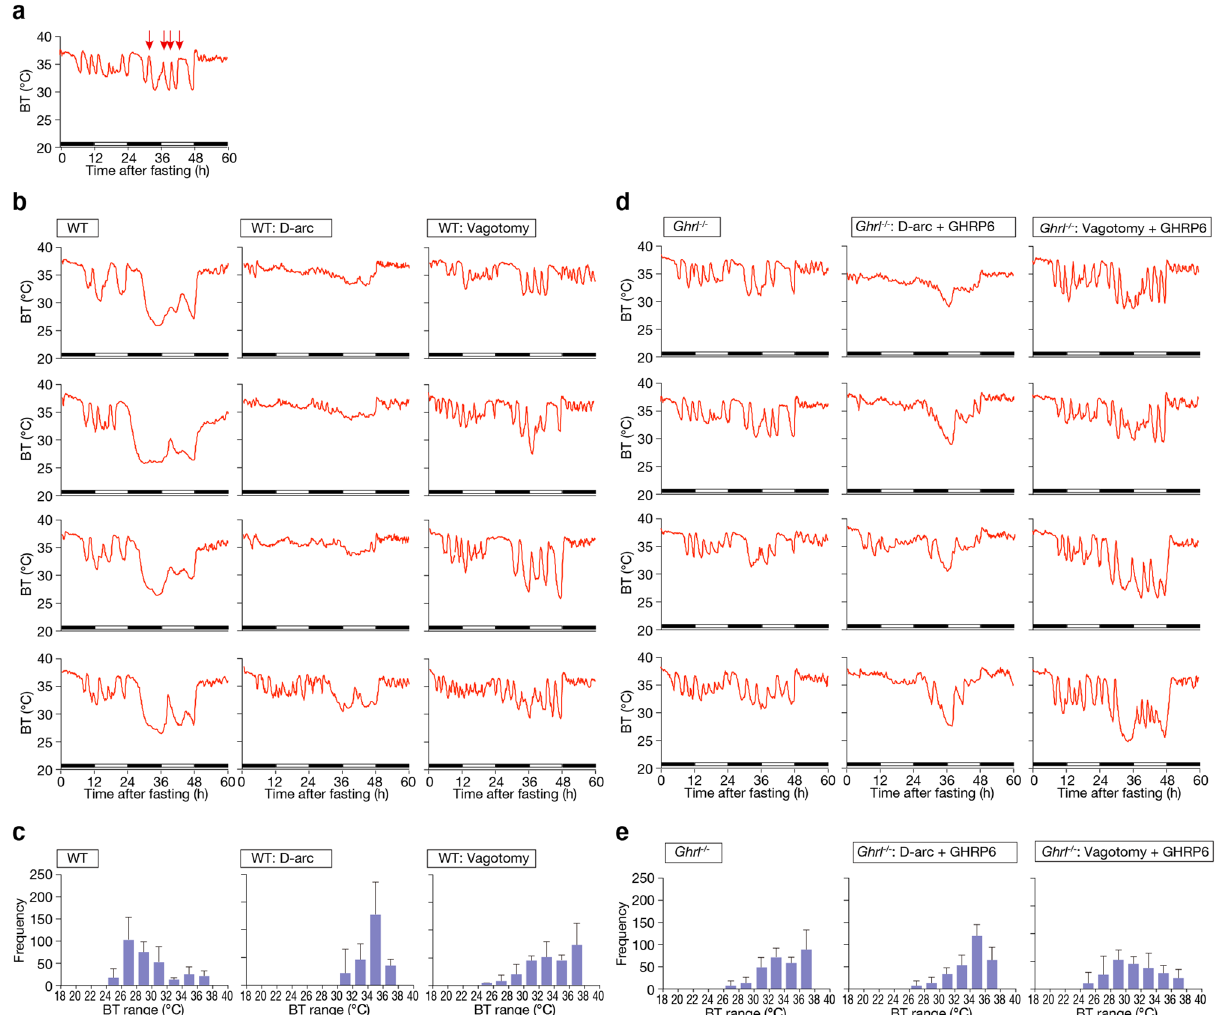
Figure 3. Ghrelin pathway and function. ( a ) Fluctuation of BT is indicated by the red arrows. As shown in ( b , d ), the fluctuation of BT is slow, cycling with a periodicity of 2–3 h. ( b ) Role of the arcuate nucleus and vagus nerve in thermoregulation during fasting in C57BL/6 J mice. Each graph shows the results for each individual; mice were re-fed 48 h after the start of fasting. Destruction of the arcuate nucleus suppressed the decrease in BT during fasting, and vagotomy destabilized the BT rhythm. D-arc: arcuate nucleus destruction. ( c ) Data from ( b ), shown as a histogram from 24 to 48 h after the start of fasting, during which torpor occurs. ( d ) Role of the arcuate nucleus and vagus nerve in thermoregulation during fasting in Ghrl −/− mice treated with an osmotic minipump filled with GHRP-6. Each graph shows the results for one individual. Mice were re-fed 48 h after the start of fasting. Destruction of the arcuate nucleus in Ghrl −/− mice treated with an osmotic minipump filled with GHRP-6 resulted in stable BT and minimal hypothermia. Vagotomy in Ghrl −/− mice treated with an osmotic minipump filled with GHRP-6 caused a large decrease in BT with occasional peaks of high BT. D-arc: arcuate nucleus destruction. ( e ) Data from Fig. 3d are shown as a histogram from 24 to 48 h after the start of